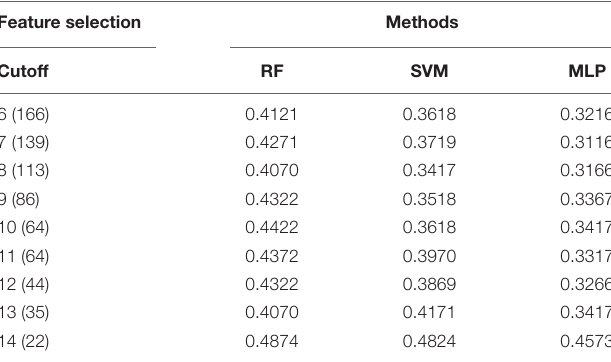
TABLE 3 | Details of the classification error rates with different